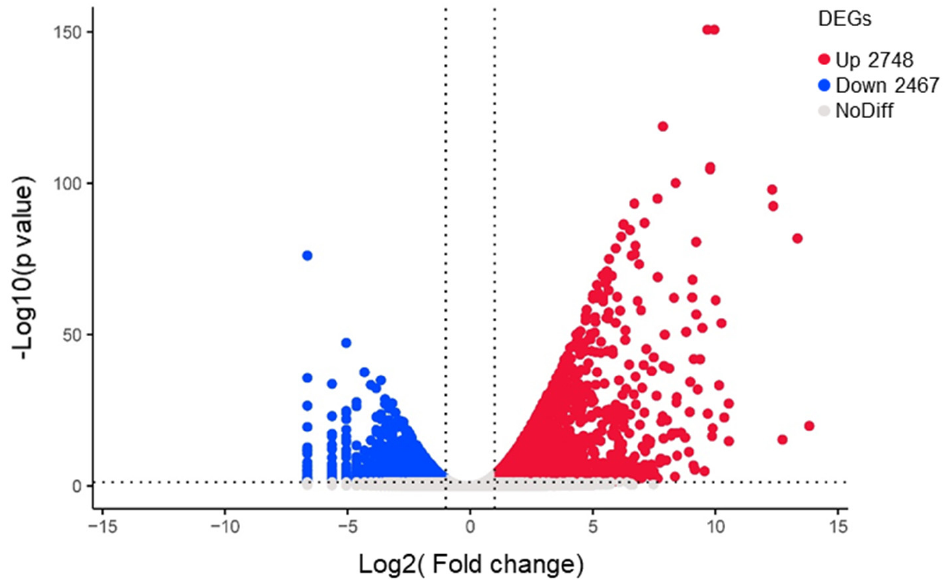
Figure 3. Differentially expressed genes (DEGs) were identified by comparing the transcriptomic profiles of drought-treated and control garlic leaves. The depicted plot was generated using an online platform (http://www.ehbio.com/Cloud_Platform/front/#/).